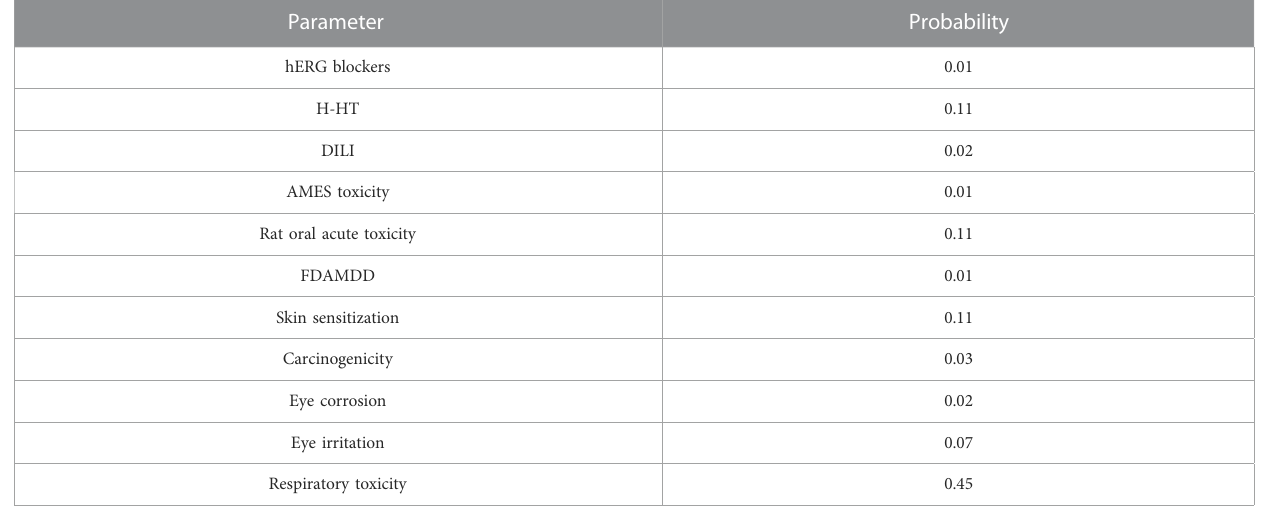
TABLE 4 Toxicity pro fi le of 4-hydroxy isoleucine calculated with ADMETLab